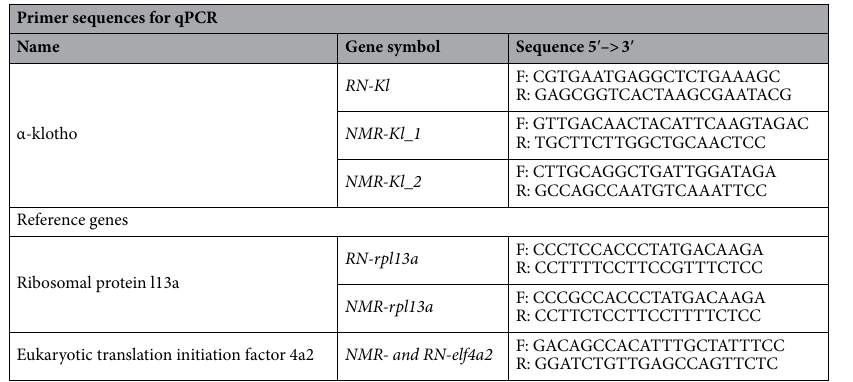
Table 2. Primer sequences for short PCR and qPCR.